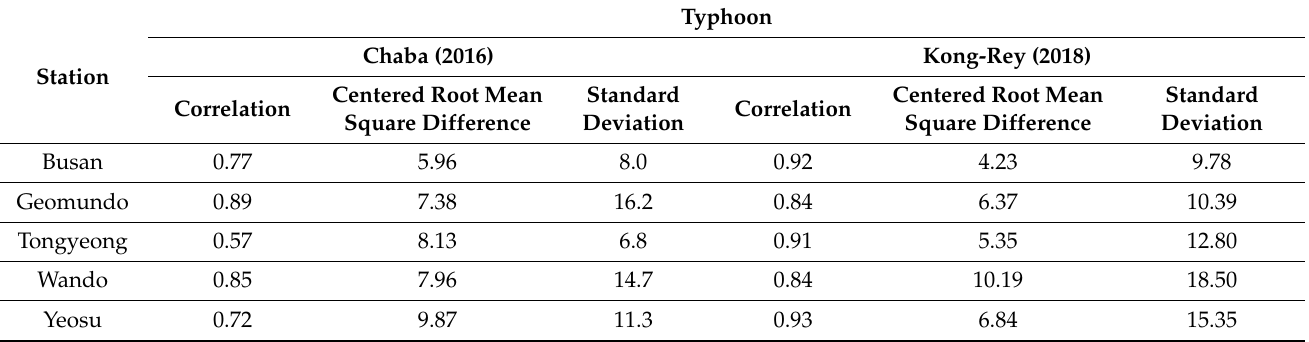
Table 5. Accuracy evaluation of the model. Correlation, centered root mean square difference, and standard deviation are calculated using the residual tide levels and predicted residual tide